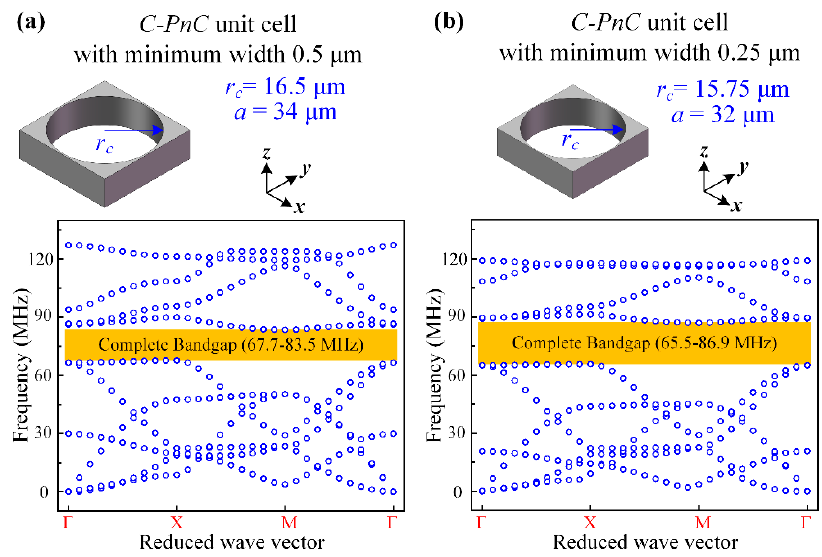
Figure 6. Dispersion relations of the C-PnC unit cell with a minimum width of ( a ) 0.5 µ m and ( b ) 0.25 µ m, respectively. Meanwhile, the mid gap frequency of these two kinds of C-PnC are approximately equal as 76 MHz.